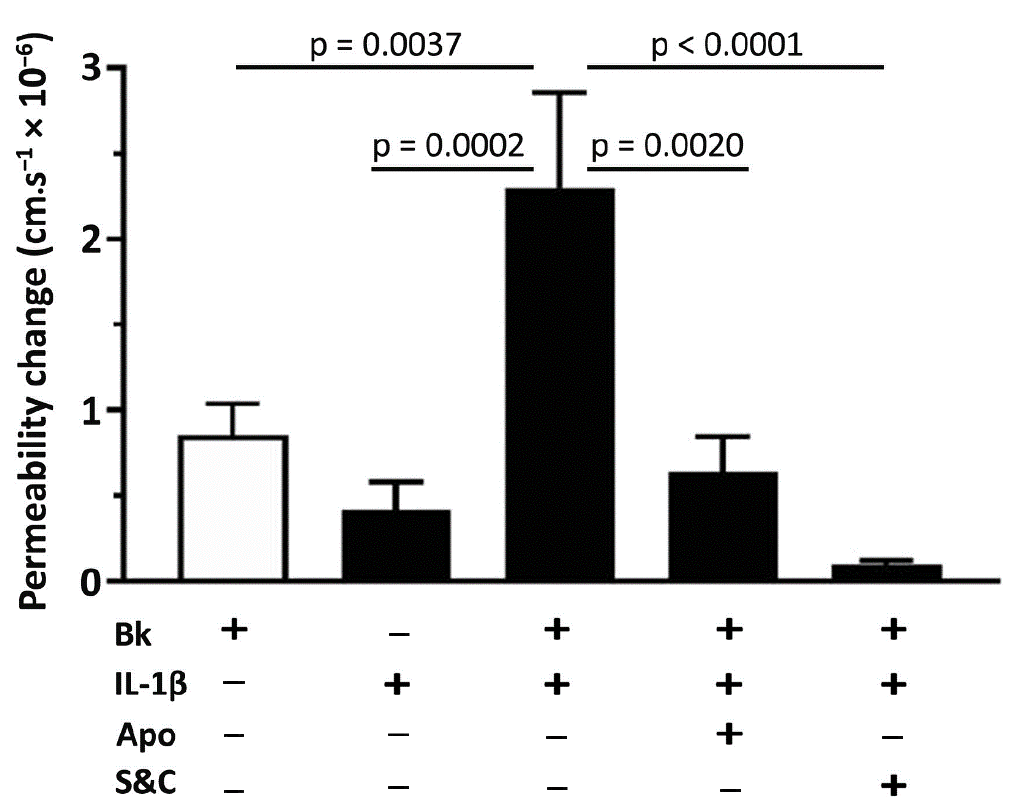
Figure 5. IL-1 β potentiates bradykinin-induced microvascular permeability and involves NADPH oxidase and reactive oxygen species. The potentiated response to bradykinin (100 nM) application, following application of IL-1 β (30 pM, 10 min), was prevented by co-application of apocynin (1 µ M) with IL-1 β (30 pM). Scavenging reactive oxygen species with superoxide dismutase (100 U/mL) and catalase (100 U/mL) completely blocked the permeability response to bradykinin. Data denote mean ± SEM, n = 10 venules from 10 animals. One-way ANOVA with Tukey’s multiple comparison test.